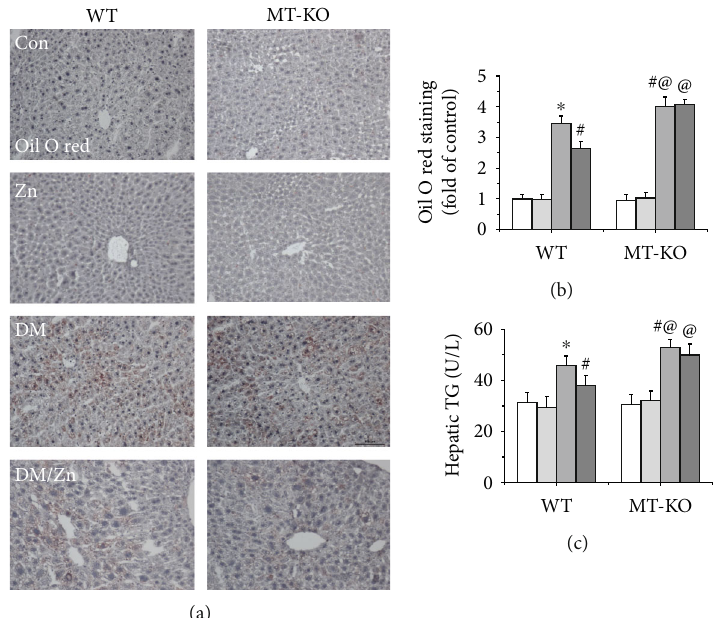
Figure 6: The role of MT in zinc supplementation-induced hepatic lipid-decreasing e ff ect in type 2 diabetic mice. Hepatic lipid accumulation was examined by Oil Red O staining (positive with brown color) (a, b), and the hepatic TG level (c) was determined by TG reagent. Data are presented as the mean ± standard deviation ( n = 8 /group). ∗ P < 0 : 05 vs. the control (Con) group in WT mice; # P < 0 : 05 vs. the type 2 diabetes (DM) group in WT mice; @ P < 0 : 05 vs. the control (Con) group in MT-KO